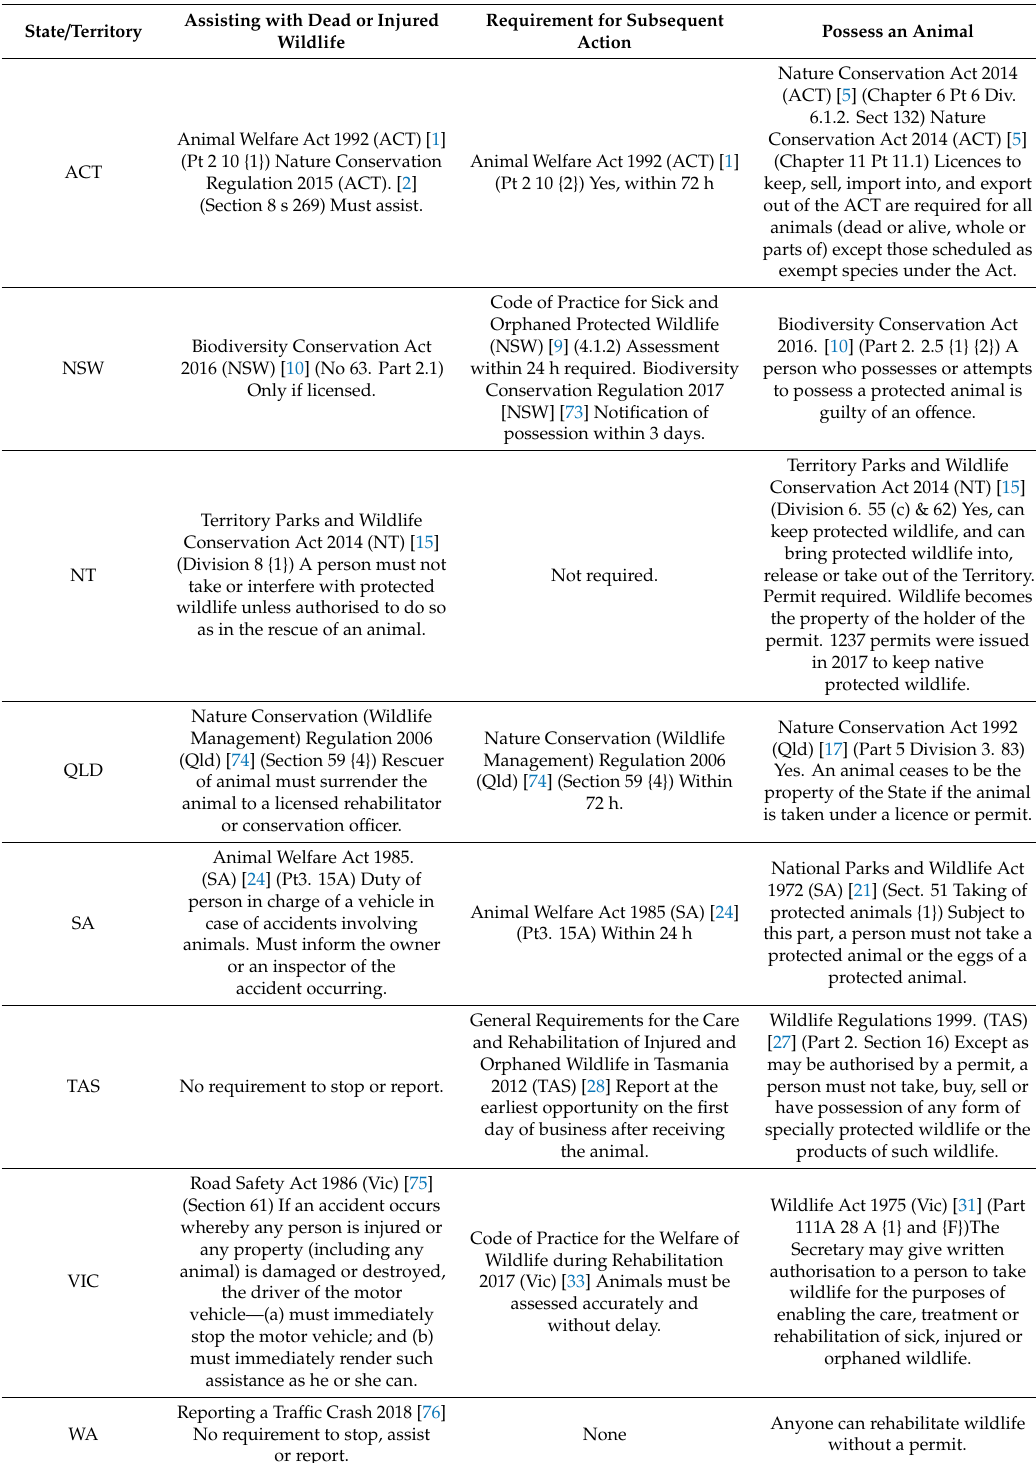
Table 2. Taking of Injured and Orphaned